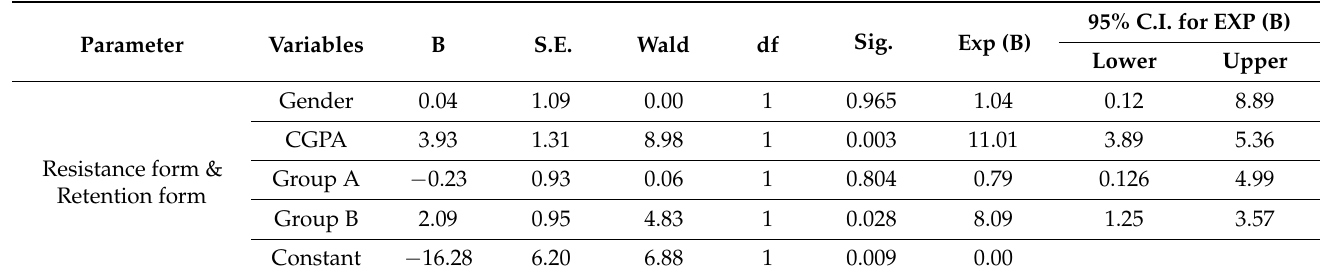
Table 7. Expressing the effect of resistance form and retention form parameter on gender, CGPA, Group A and Group B using binary logistic regression